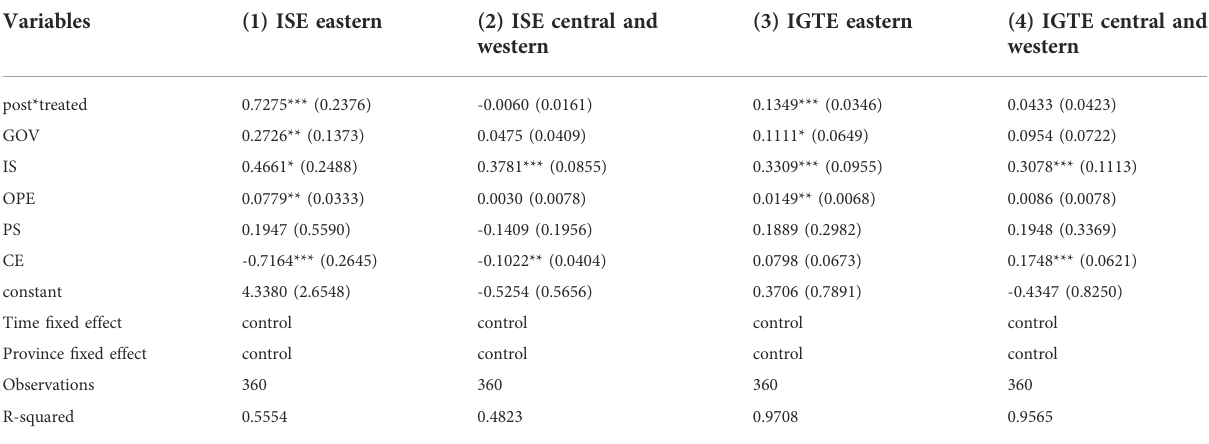
TABLE 6 Regional heterogeneity